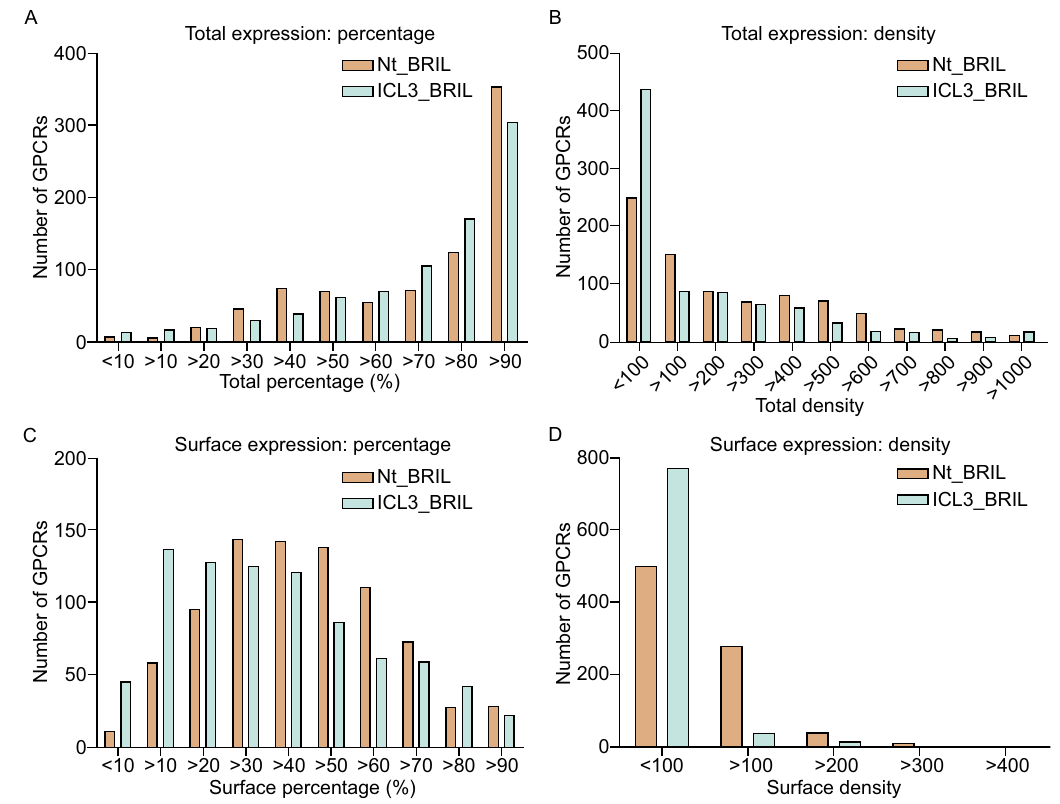
Figure 3. Distribution of total and surface expression among constructs. Comparison of total expression percentage (A), total expression density (B), surface expression percentage (C), and surface expression density (D) between Nt_BRIL and ICL3_BRIL constructs